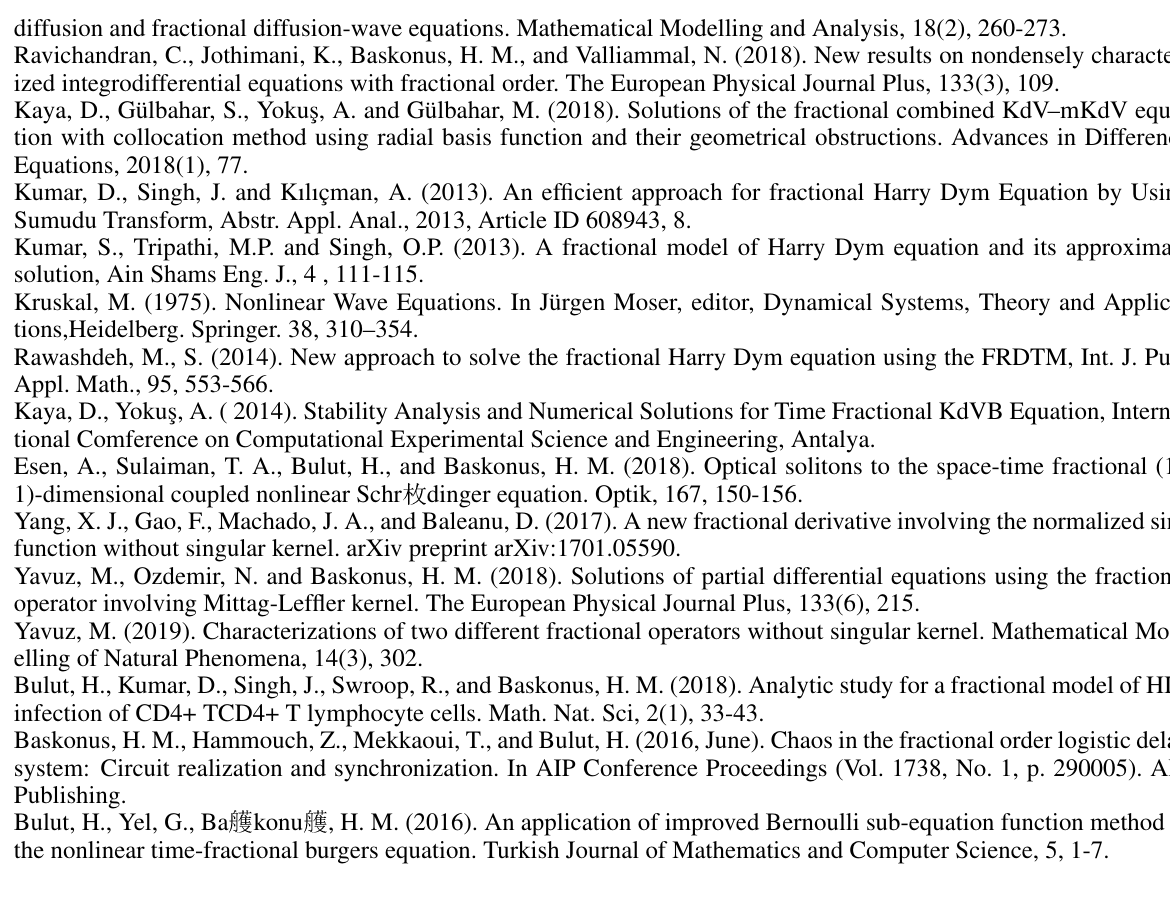
Fig. 3 Comparison of the exact and approximate solution for linearization 1, linearization 2, and linearization 3 at h = 0 .